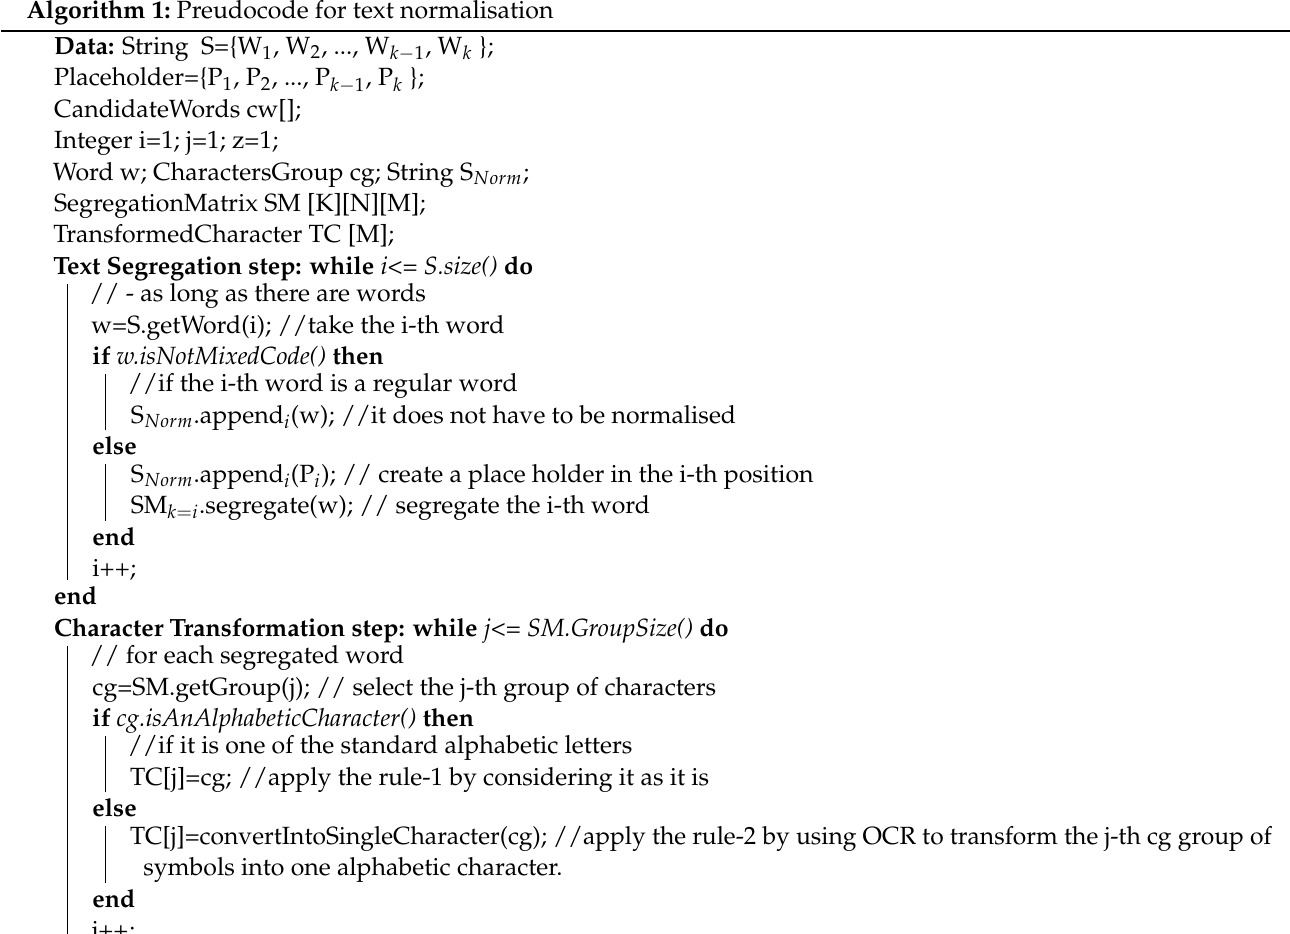
Algorithm 1: Preudocode for text